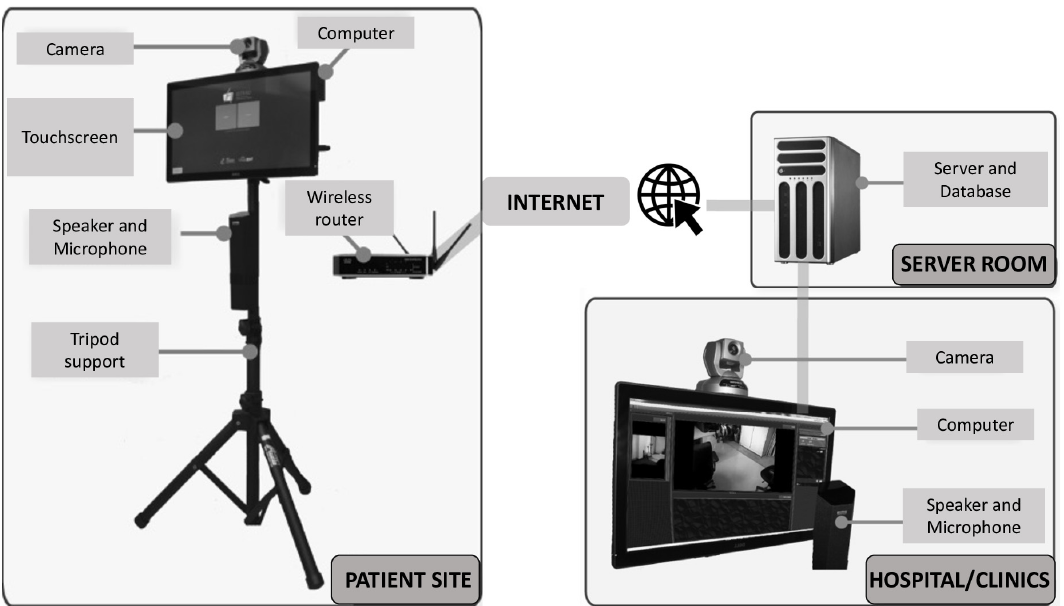
Figure 2. Representation of the telerehabilitation system used in the study.